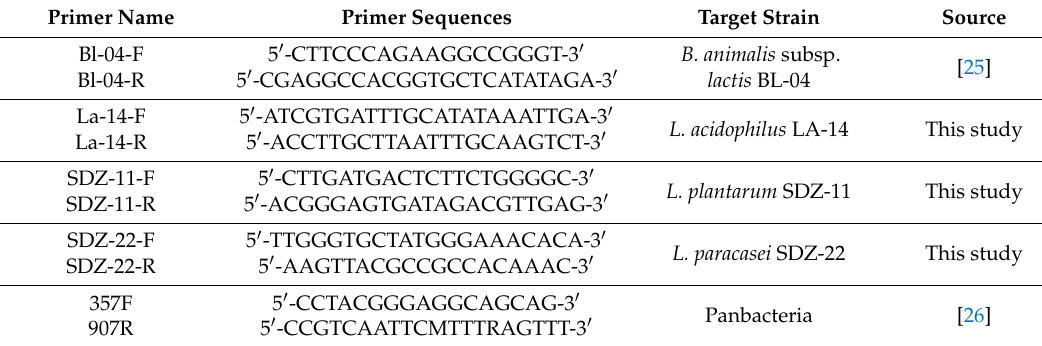
Table 2. Primer sets used for the qPCR experiments in the ECoCePPI